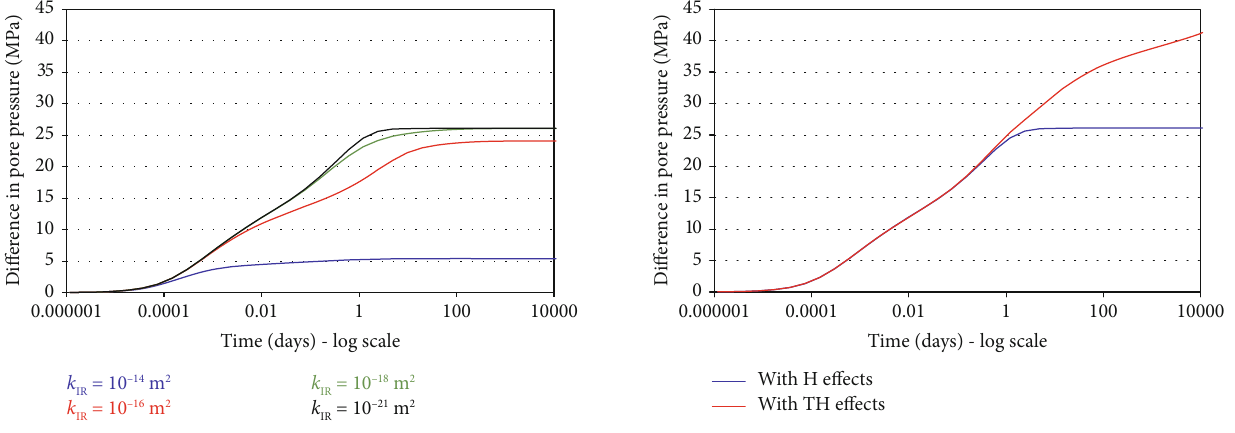
Figure 6: Variation with time of the di ff erence in the fl uid pore pressure between the injection and production boreholes, obtained for several values of the permeability k IR of the intact rock.